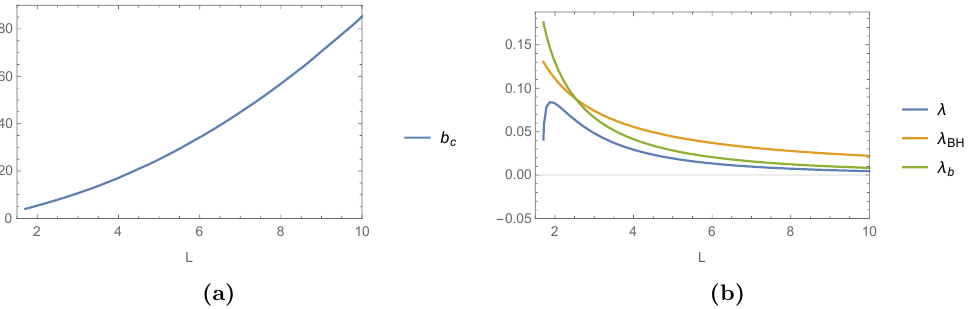
Figure 7. Critical impact parameter b c (a) and Lyapunov exponent (b) as a function of the fuzzball charge L , for a = 1, R = 1 and n =